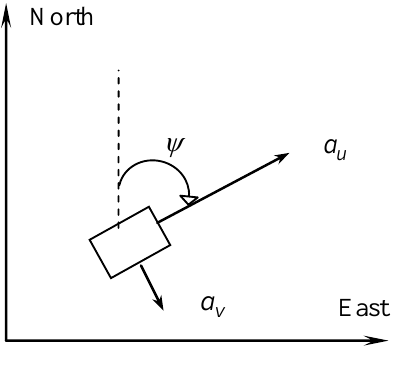
Figure 5. Illustration of the two-dimensional inertial